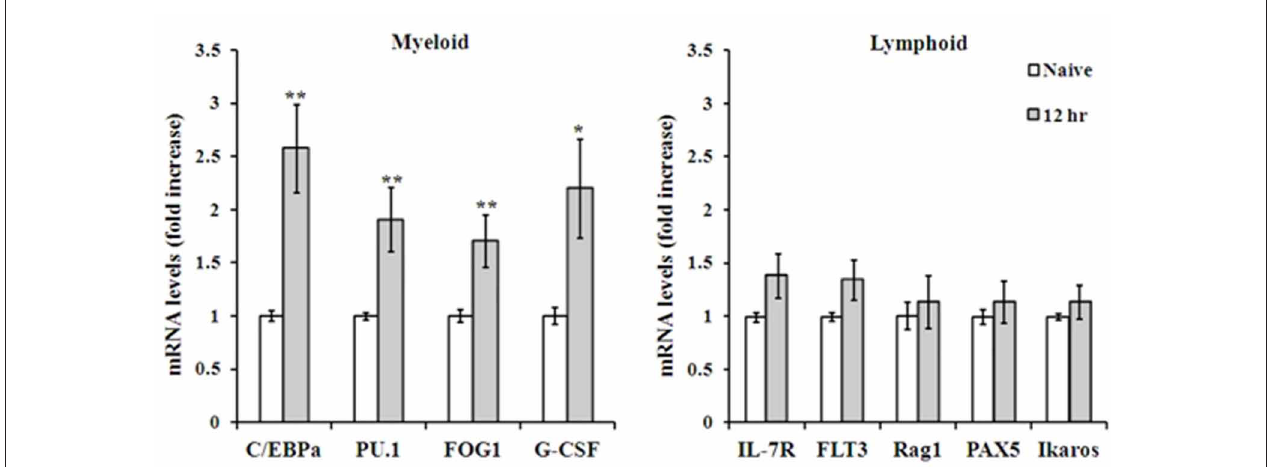
lineage differentiation, as determined by quantitative PCR of total BM cells mRNA, 12h post i.n. infection with Kim53. ∗ p < 0 . 05; ∗∗ p < 0 . 01 compared with naïve mice.